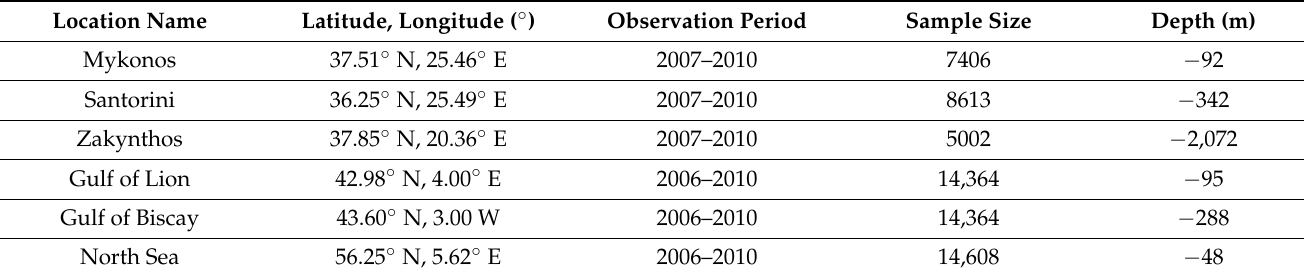
Table 1. Location names, geographical coordinates, observation periods, sample size, and depth of wave data sets. Location